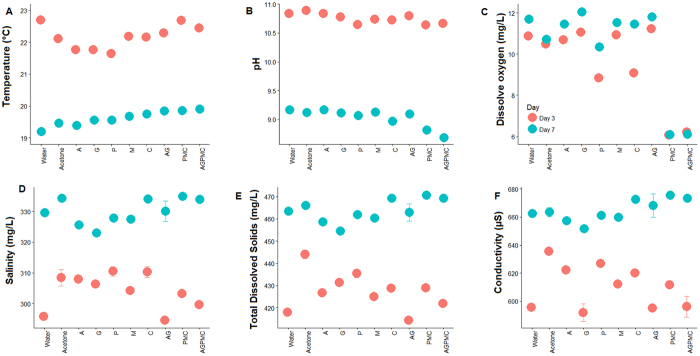
Temporal variation in the physical and chemical characteristics of the water samples (Mean ± SE) in relation to pesticide treatments.A = atrazine; G = glyphosate; P = permethrin; M = Malathion; C = carbaryl; AG = atrazine + glyphosate; PMC = permethrin + malathion + carbaryl; AGPMC = atrazine + glyphosate + permethrin + malathion + carbaryl. Error bars were too small and not visible in most data point.